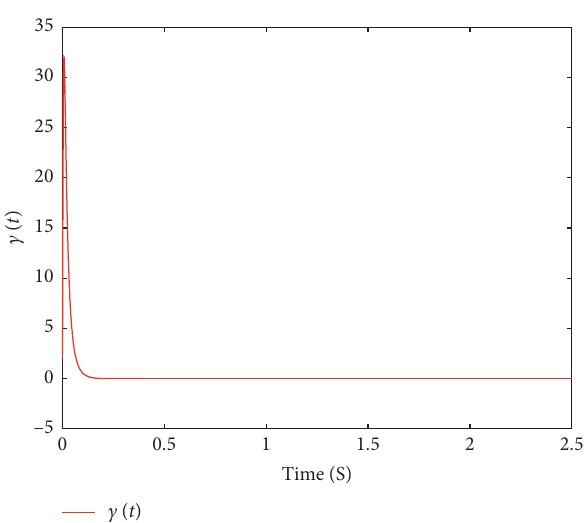
Figure 7: The trajectory of adaptive updated law c ( t ) by controller